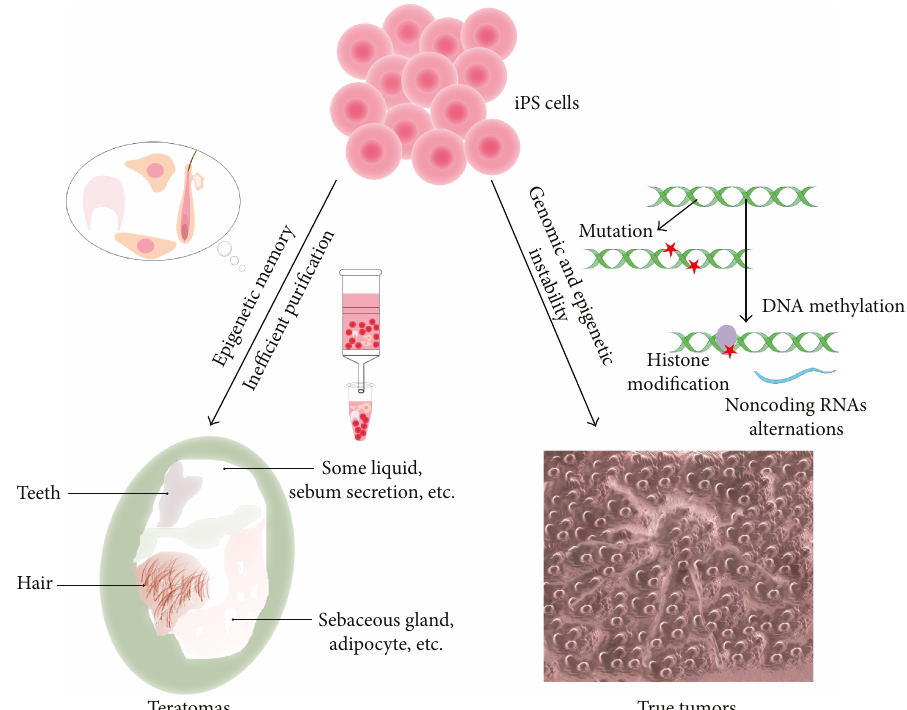
Figure 1: Two distinguished aspects of tumorigenicity and respective potential mechanisms. The tumorigenicity of iPSCs included two parts: one of them is teratoma formation and another is substantial tumor formation. The former is mostly attributed to epigenetic memory as well as ine ffi cient puri fi cation, while the latter is ascribed to genomic instability and epigenetic